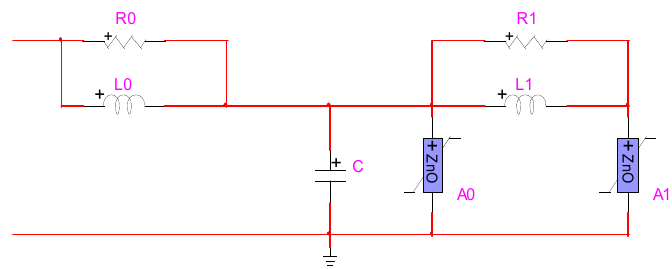
Figure 21. Frequency-dependent metal oxide surge arrester.